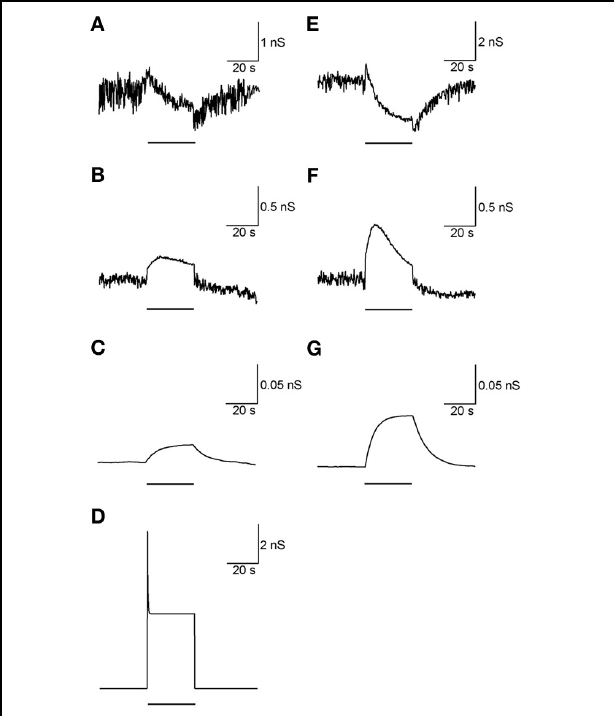
FIGURE 5 | Synaptic conductance during LFS and HFS. (A–D) Synaptic conductance during 10Hz stimulation of GP-GP synapses (A) , STN-GP ionotropic synapses (B) , STN-GP metabotropic synapses (C) and Str-GP synapses (D) . (E–G) Synaptic conductance during 40Hz stimulation of GP-GP synapses (E) , STN-GP ionotropic synapses (F) and STN-GP metabotropic synapses (G) . Horizontal bars indicate the stimulation period.